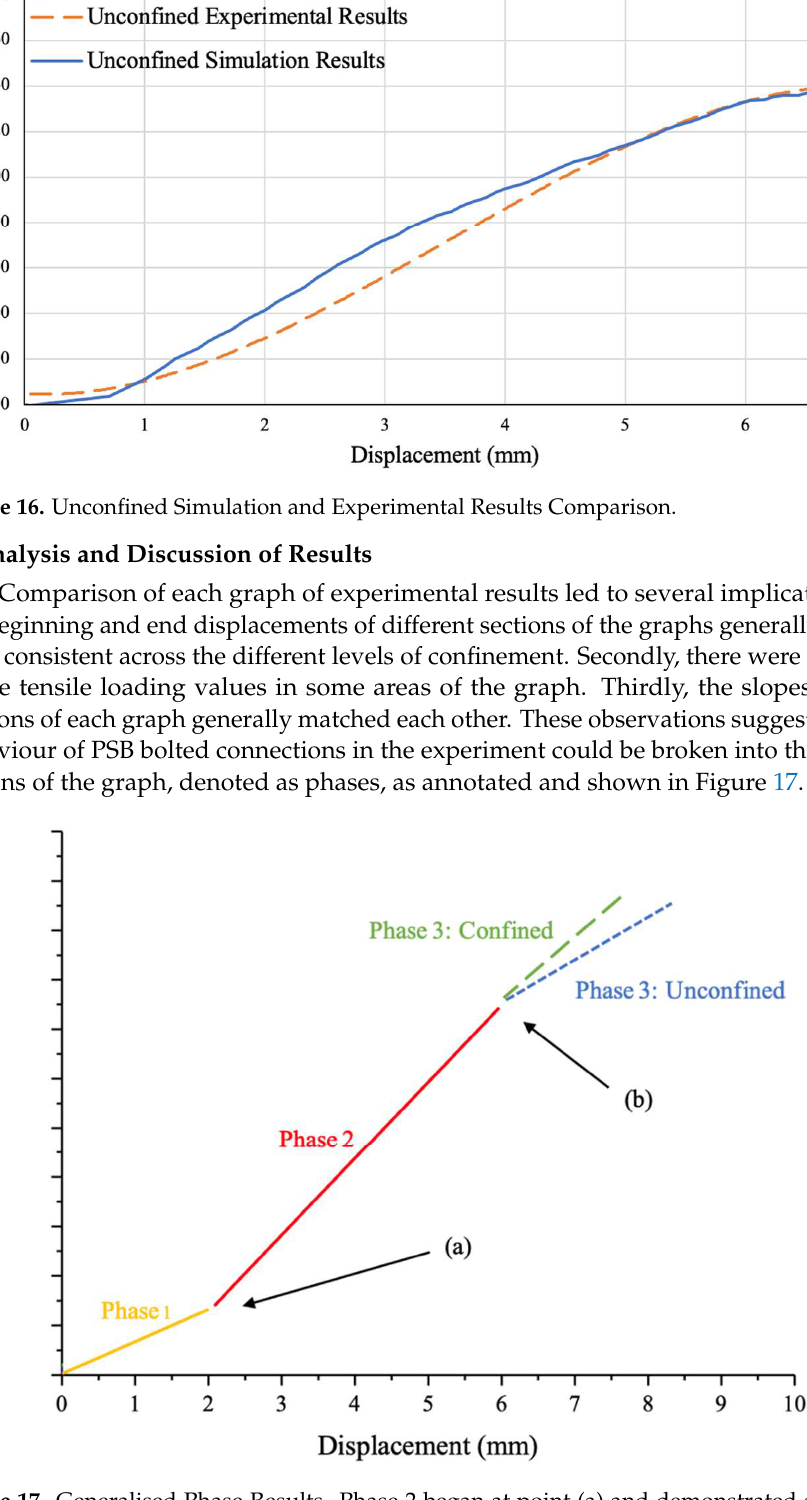
Figure 16. Generalised Phase Results. Phase 2 began at point (a) and demonstrated a significant increase in slope from Phase 1, suggesting an increase in connection stiffness under loading. This slope continued until the end of the phase at point